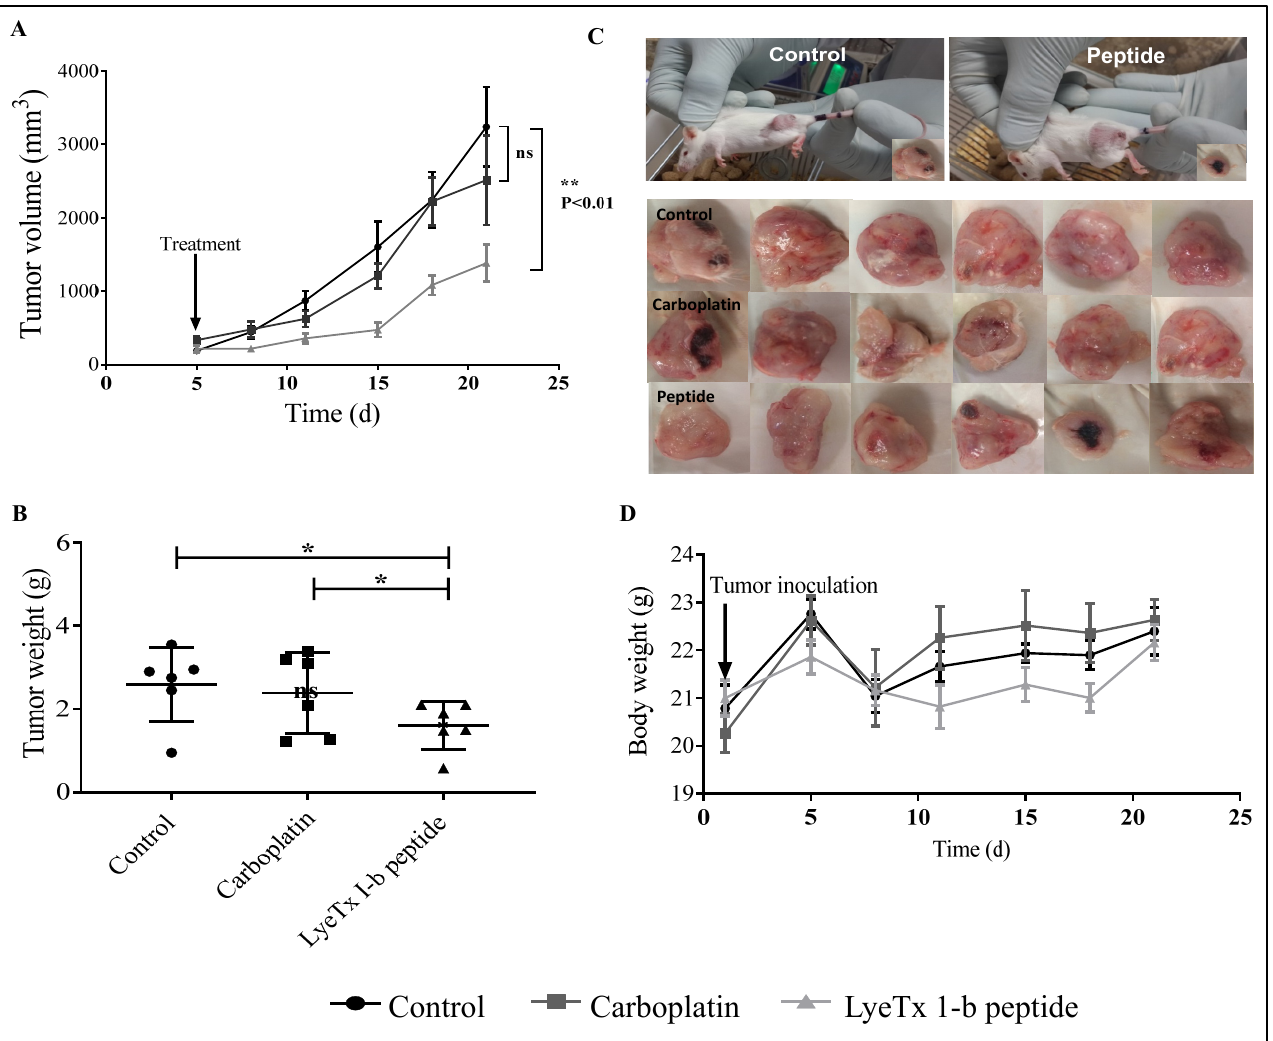
Figure 7. Effects of subcutaneous LyeTx I-b treatment on tumor volume, tumor weight, and body weight after 4T1 murine